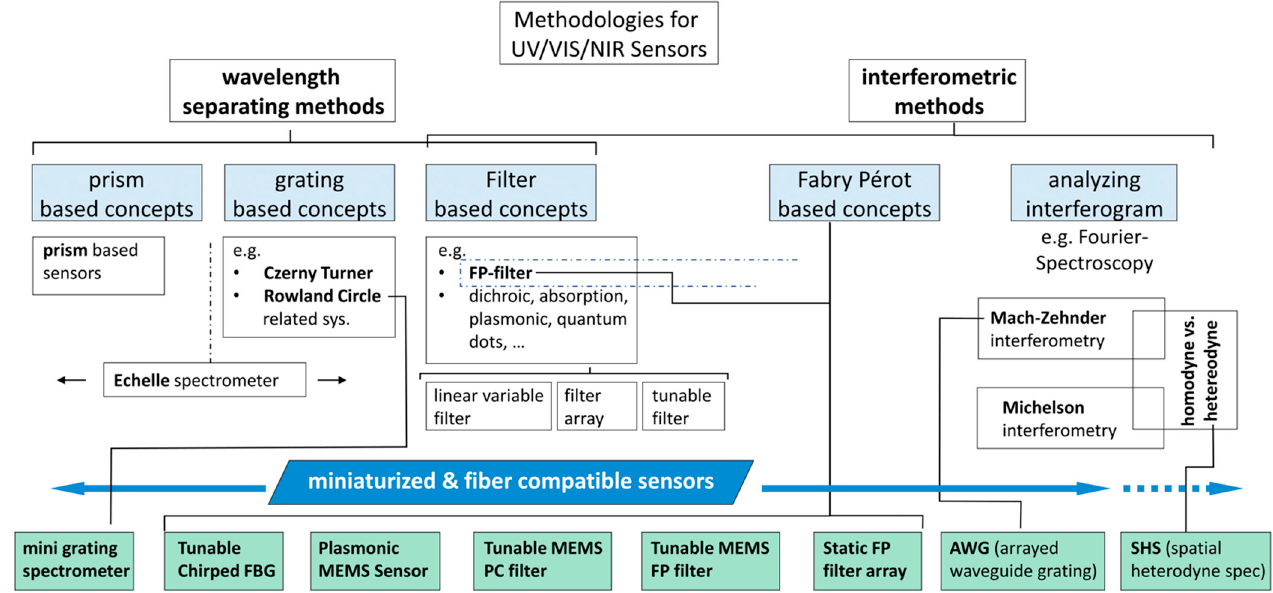
Figure 1. Block diagram of the sensor and spectrometer types considered in this review. This diagram should provide a general overview and an orientation throughout this extensive paper.